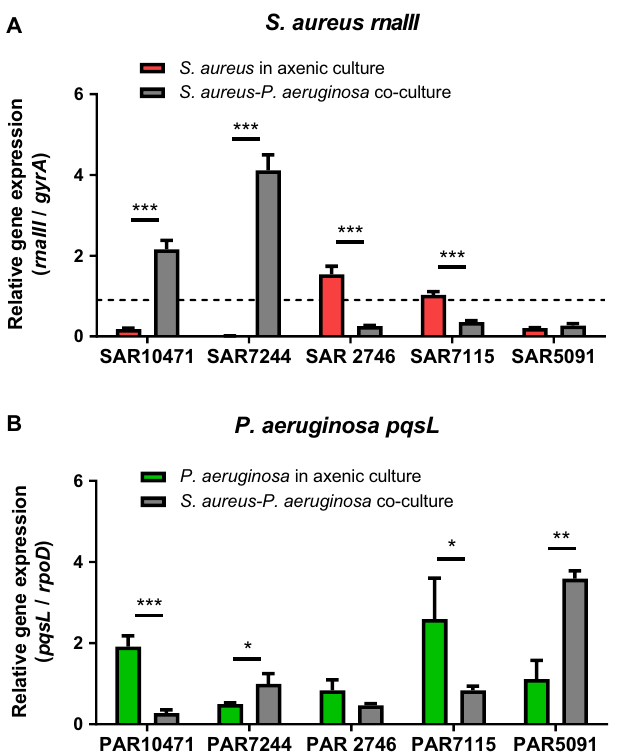
Figure 5. Differential deregulation of genes controlled by quorum sensing in co-culture. Relative expression of quorum sensing genes in co-cultures of S. aureus and P. aeruginosa in modified artificial sputum (ASM) medium (1:1 mix of ASM and 0.5X TSB with 1% glucose) assayed by qRT-PCR. ( A ) Effect of P. aeruginosa on rnaIII expression in S. aureus . Horizontal dashed line denotes the cut-off used to discriminate between Agr functional and dysfunctional strains (see methods). ( B ) Effect of S. aureus on pqsL expression in P. aeruginosa . In all experiments error bars indicate standard deviation of three biological